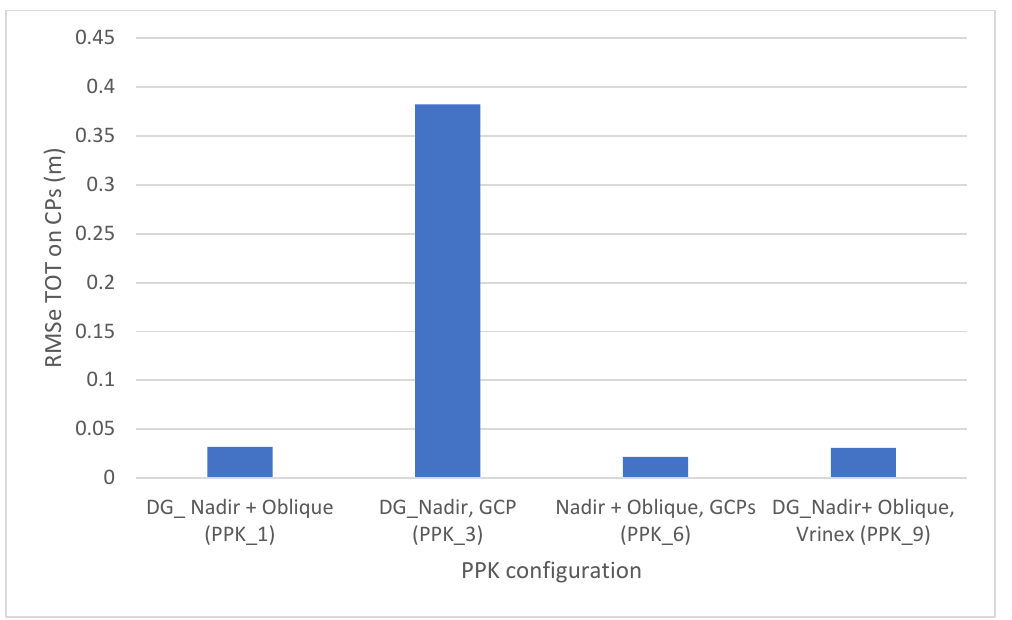
Figure 4. RMSE TOT on CPs for different PPK configurations (PPK_1, PPK_3, PPK_6, and PPK_9).